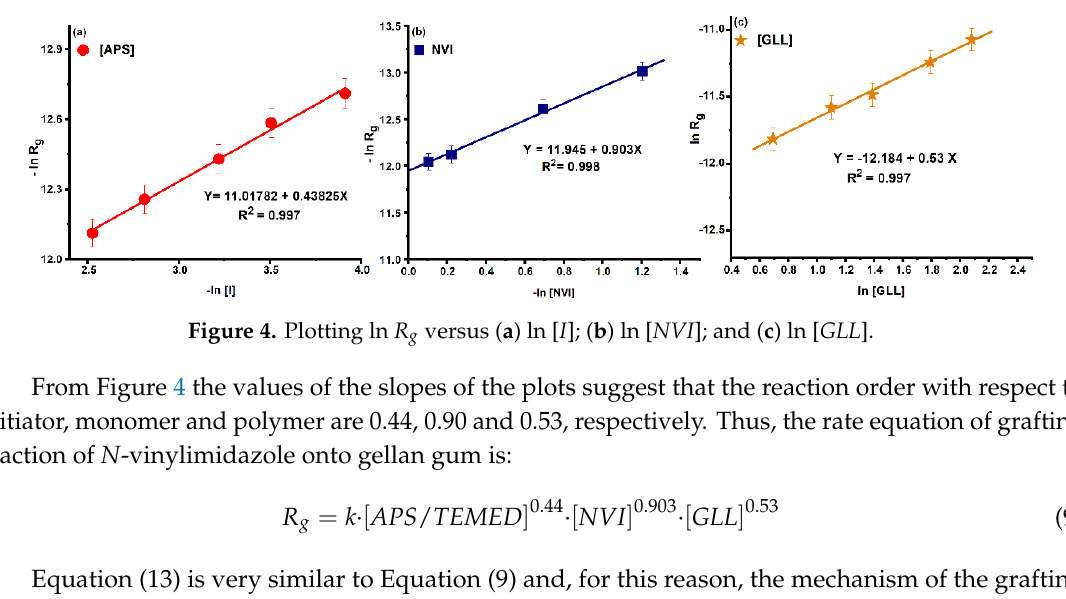
Figure 6. Propagation step of grafting copolymerization. The termination reactions depend on the size, activity and structure of the macroradical, the viscosity of the medium, the temperature and the composition of the reaction mixture (Figure 7).